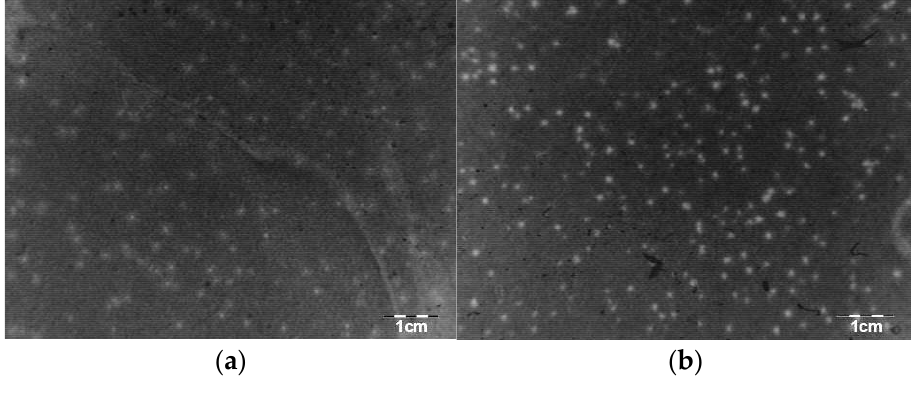
Figure 1. Plaque morphology ( a ) LASTA; ( b ) SJM3.